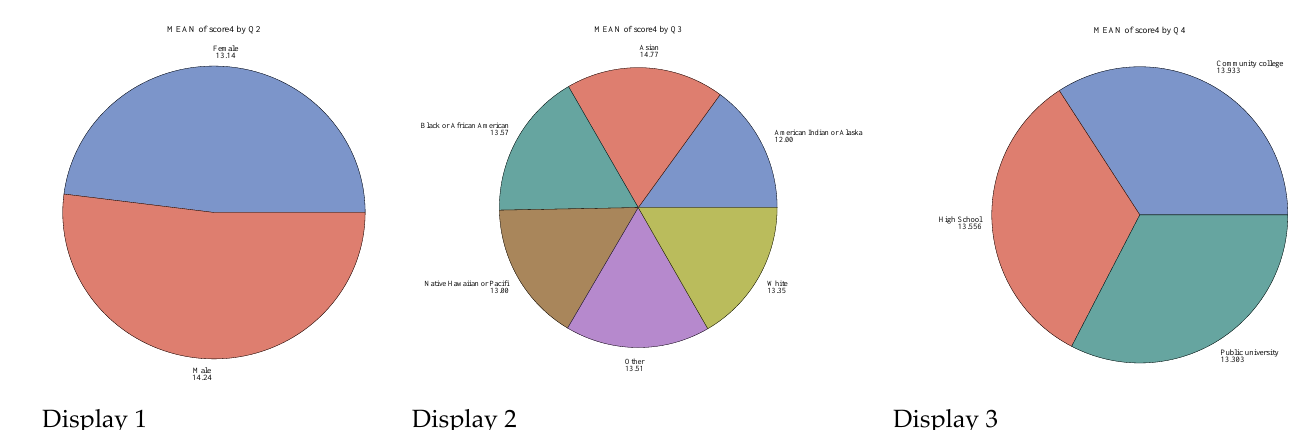
Figure 1. Pie charts of Scores 1–4 by gender, race, and schooling method.